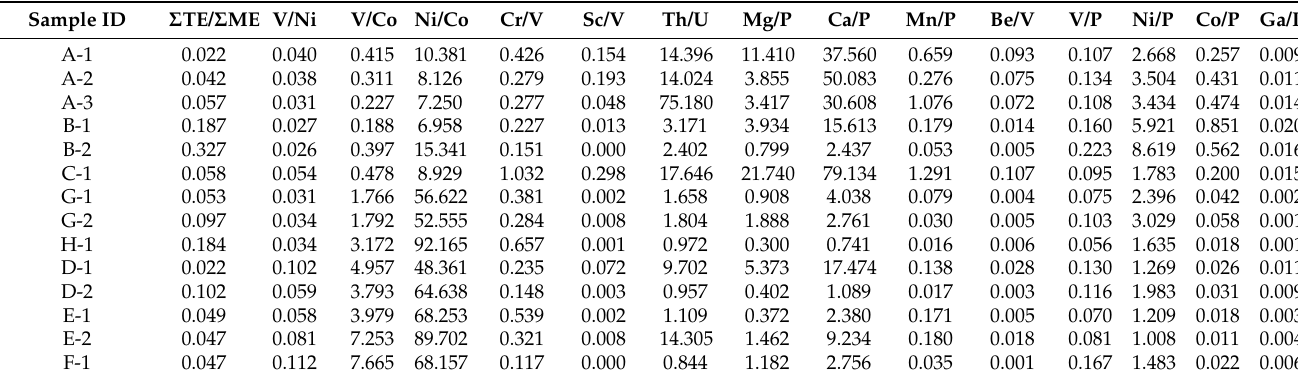
Table 3. Ratios of major and trace elements in the studied oil